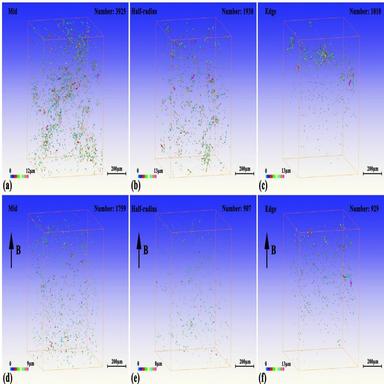
3D characterization of inclusions at different regions in LMF (with or without ASMF) in this study, (a) Mid region without ASMF, (b) Half-radius region without ASMF, (c) Edge region without ASMF, (d) Mid region with ASMF, (e) Half-radius region with ASMF, (f) Edge region with ASMF, respectively.